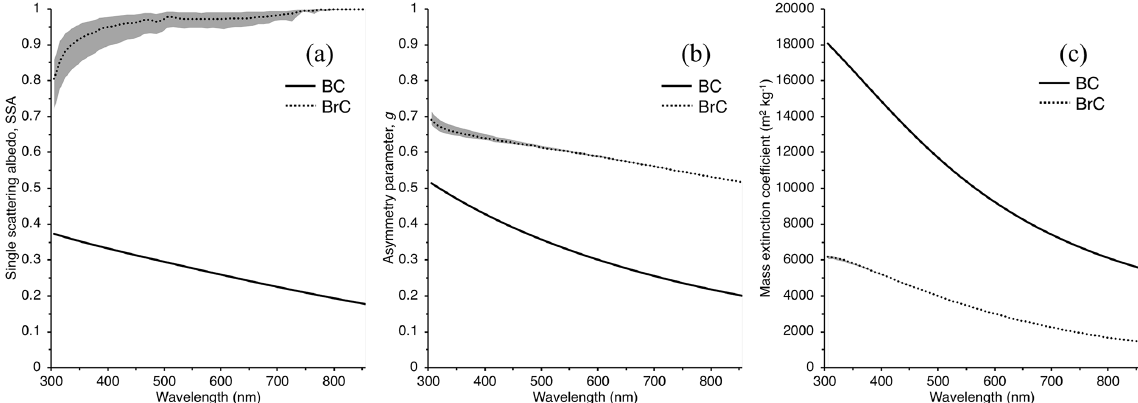
Figure 7. Single scattering albedo (SSA, a ), asymmetry parameter ( g , b ), and mass extinction coefficient (MEC, m 2 kg − 1 , c ) of BrC derived using Mie theory. BC optical properties used in the SNICAR model are provided for reference. The grey area represents the outputs of each parameter for the range of κ BrC retrievals used in the Mie code, where the largest relative discrepancy lies in the SSA. Note that the real refractive index for the calculations presented in this figure is assumed to be n λ = 1 . 6 across all